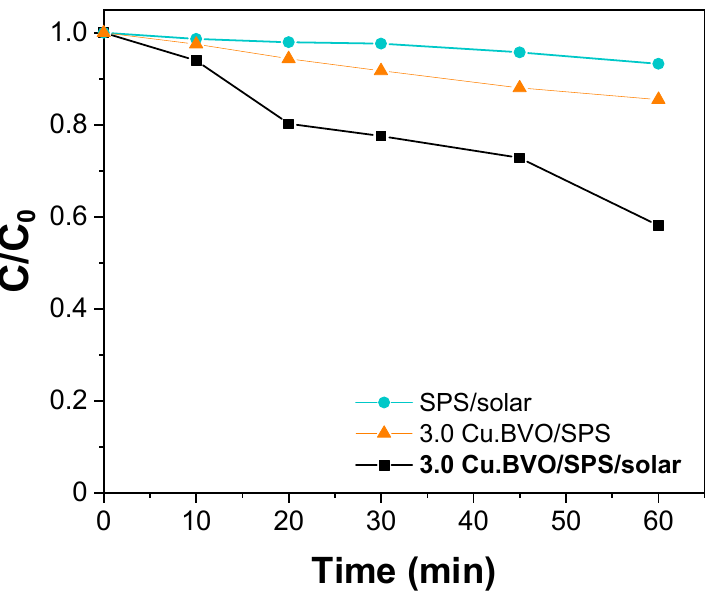
Figure 12. SPS consumption by solar/SPS, SPS/catalyst, and solar/SPS/catalyst for 3.0 Cu.BVO. Experimental conditions: 0.5 mg/L SMX, 100 mg/L SPS, and 500 mg/L catalyst. For example, after 60 min the consumption of persulfate was 7%, 14%, and 4% for SPS/Solar, 3.0 Cu.BVO/SPS, and the hybrid 3.0 Cu.BVO/SPS/solar system, respectively. Taking the aforementioned into consideration, the SMX degradation mechanism in the combined process can be described as follows: Under solar light irradiation,